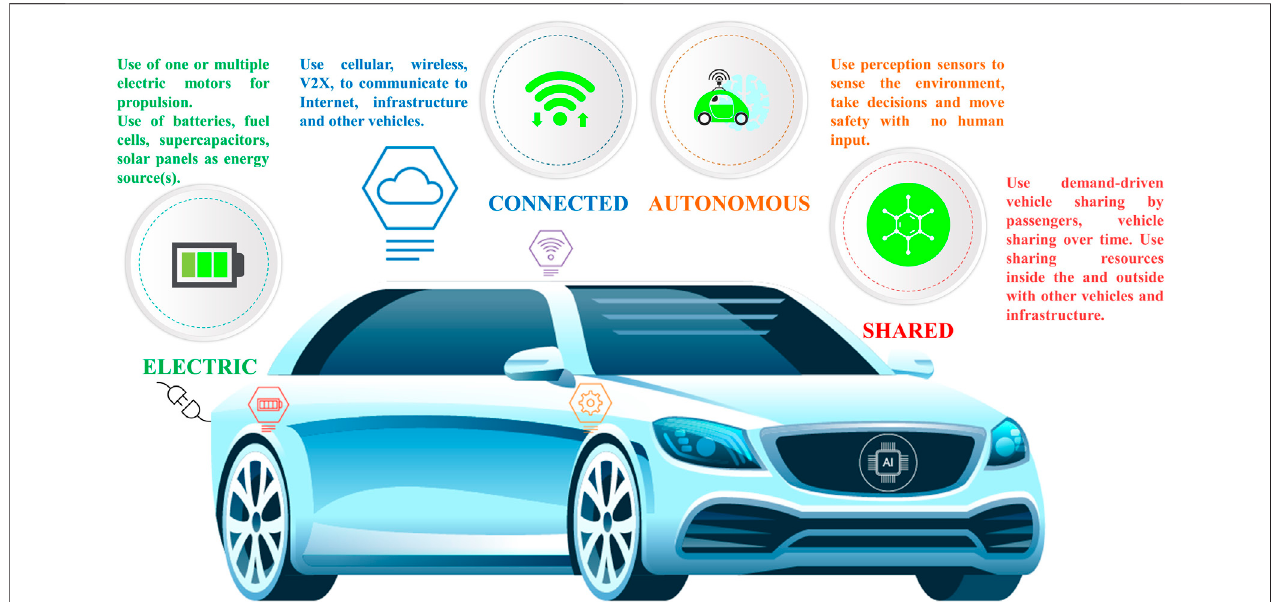
FIGURE 2 | Electric Connected Autonomous Shared (ECAS)